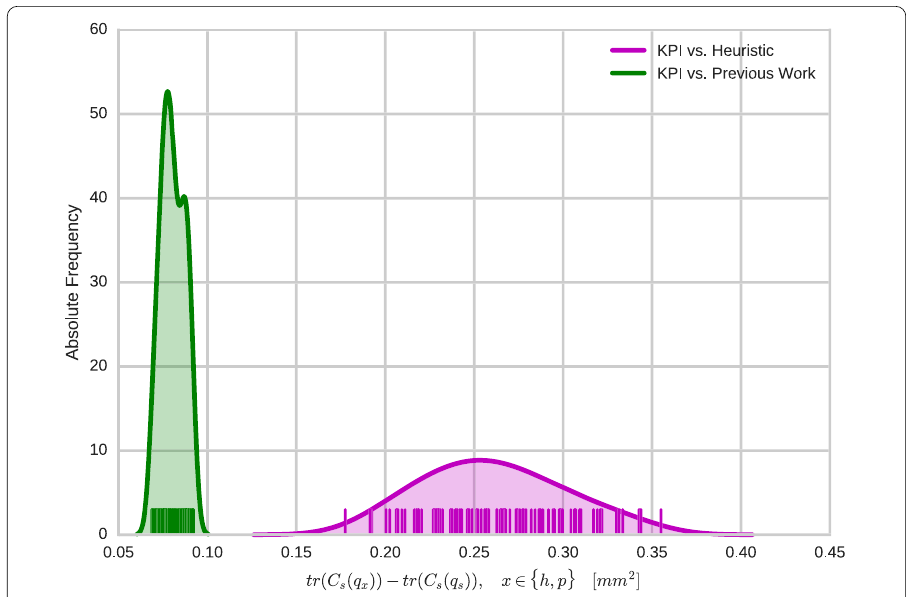
Figure 8 Kernel density estimations of the position precision of the tool center point (TCP) between the new approach using key performance indicator and (a) the heuristic approach and (b) the state-of-the-art optimization approach. The Histogram presents the difference of TCP precision of working configuration q work from the new approach using KPI and the heuristic/state-of-the-art optimized measurement configurations q meas x , where x ∈ { h , p } for 90 parameter identifications differing in the industrial manipulators’ models. Higher values on the x -axis mean a better result of the new approach. The optimized measurement configurations q p and q s result by solving the optimization problems: